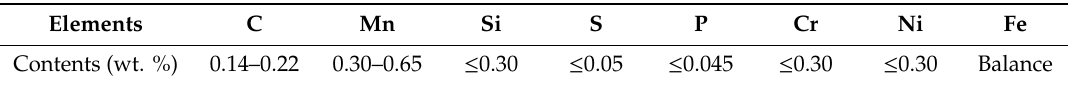
Table 1. Chemical composition of Q235 steel (wt. %).